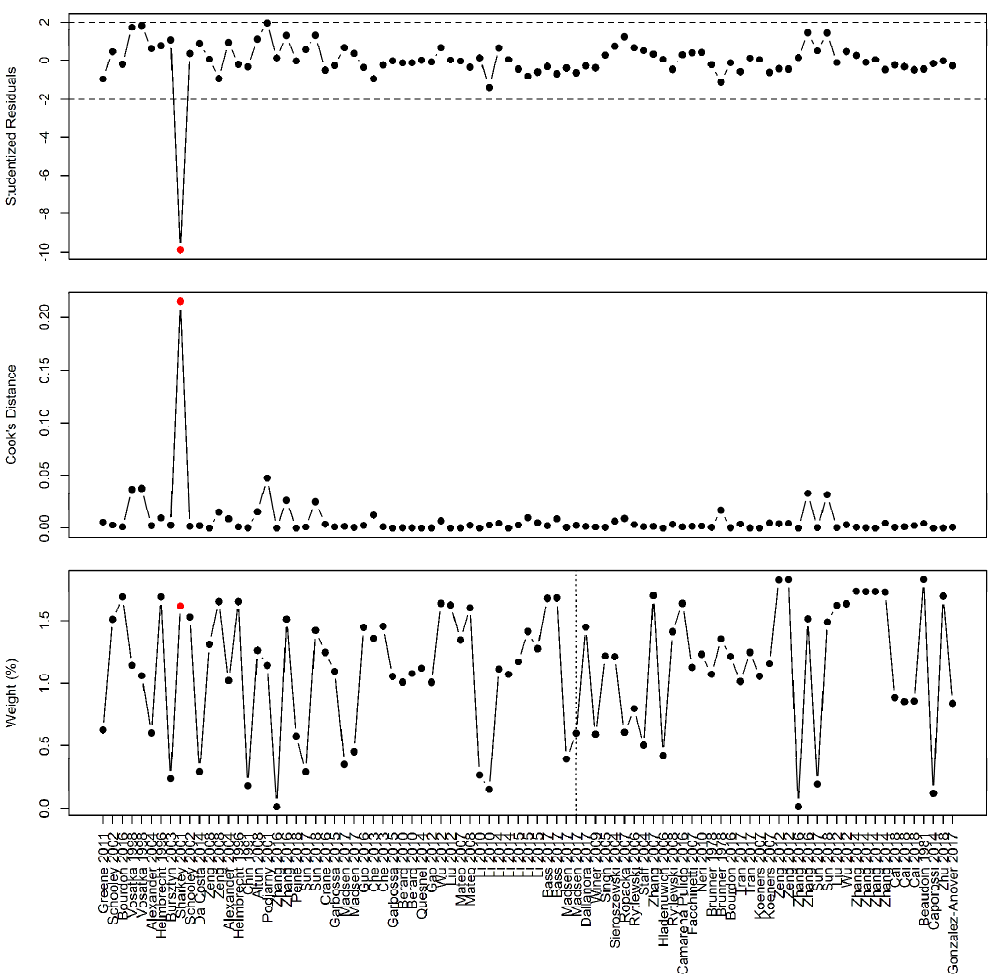
Figure A2. Influential case analysis of studies reporting on arginine family supplementation and fetal/birth weight. Sensitivity analysis revealed Sharkey et al. as an influential case [51].